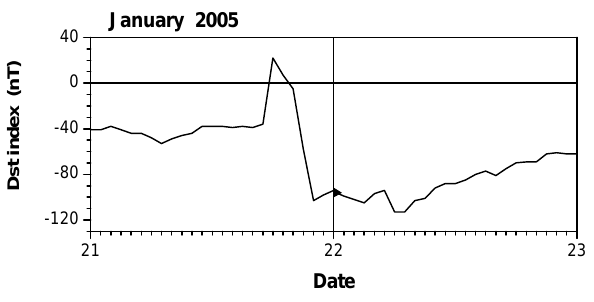
Fig. 2. The development of the D st index on 21–22 January 2005. Between 00:00–01:00UT , (marked with a black triangle), the D st index was about −